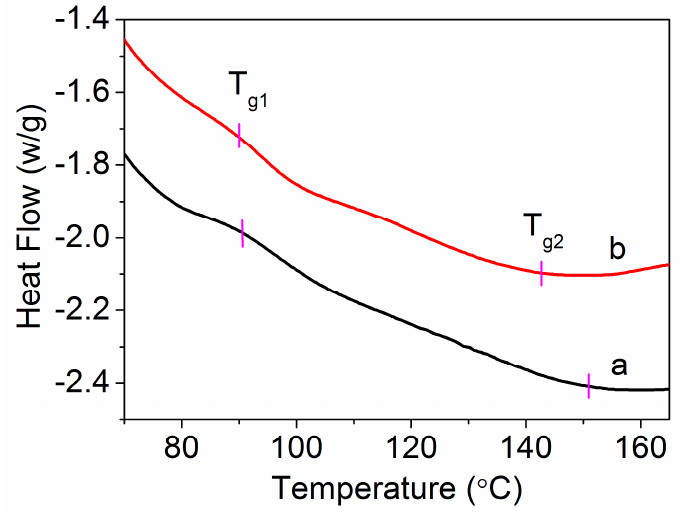
Figure 7. The T g of ( a ) PAN homopolymer and ( b ) amino-CNT/PAN microspheres.